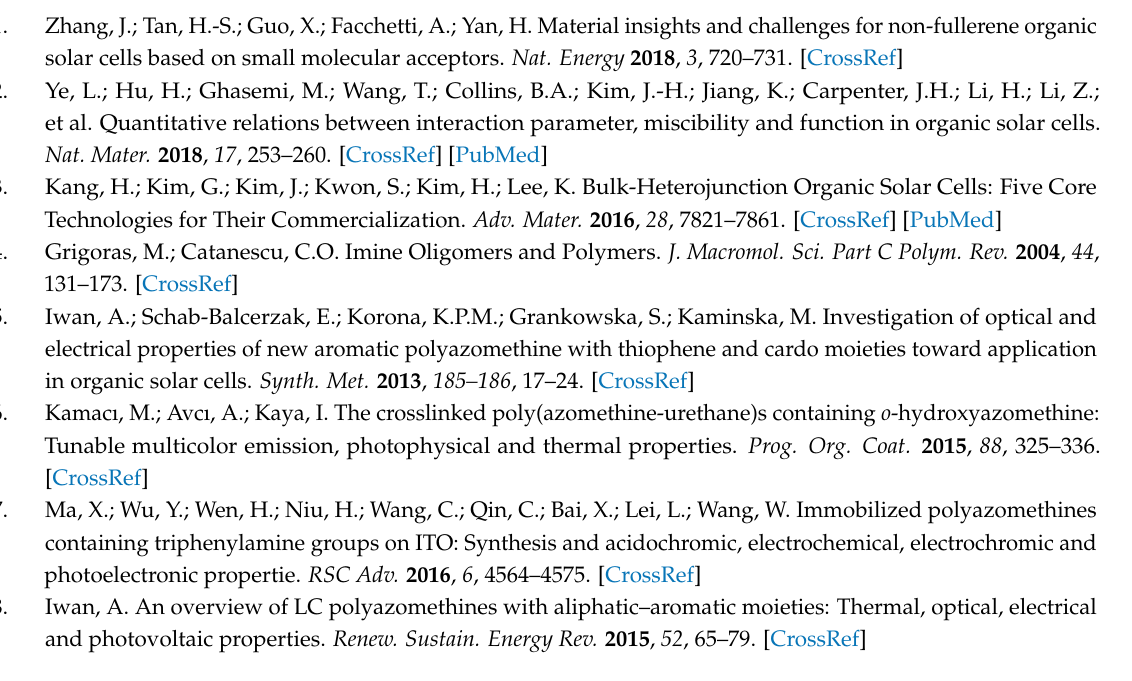
Figure S1: NMR spectra (CDCl 3 ) of diamine A1 . a) 1 H NMR and b) 13 C NMR, Figure S2: FT-IR spectrum (KBr pellets) of diamine A2, Figure S3: FT-IR spectrum (KBr pellets) of diamine A3, Figure S4: 1 H NMR spectra (CDCl 3 , 400 MHz) of diamine A3, Figure S5: 13 C NMR spectra (CDCl 3 , 101 MHz) of polySBs, Figure S6: Thermal analysis of polySBs. a) DTGA and b) DSC, Figure S7: Cyclic voltammograms of polySBs at 15 cycles measurements in 0.1 M Bu 4 NPF 6 in dichloromethane, at a scan rate of 100 mV s − 1 , Figure S8: Redox process of the nitrogen